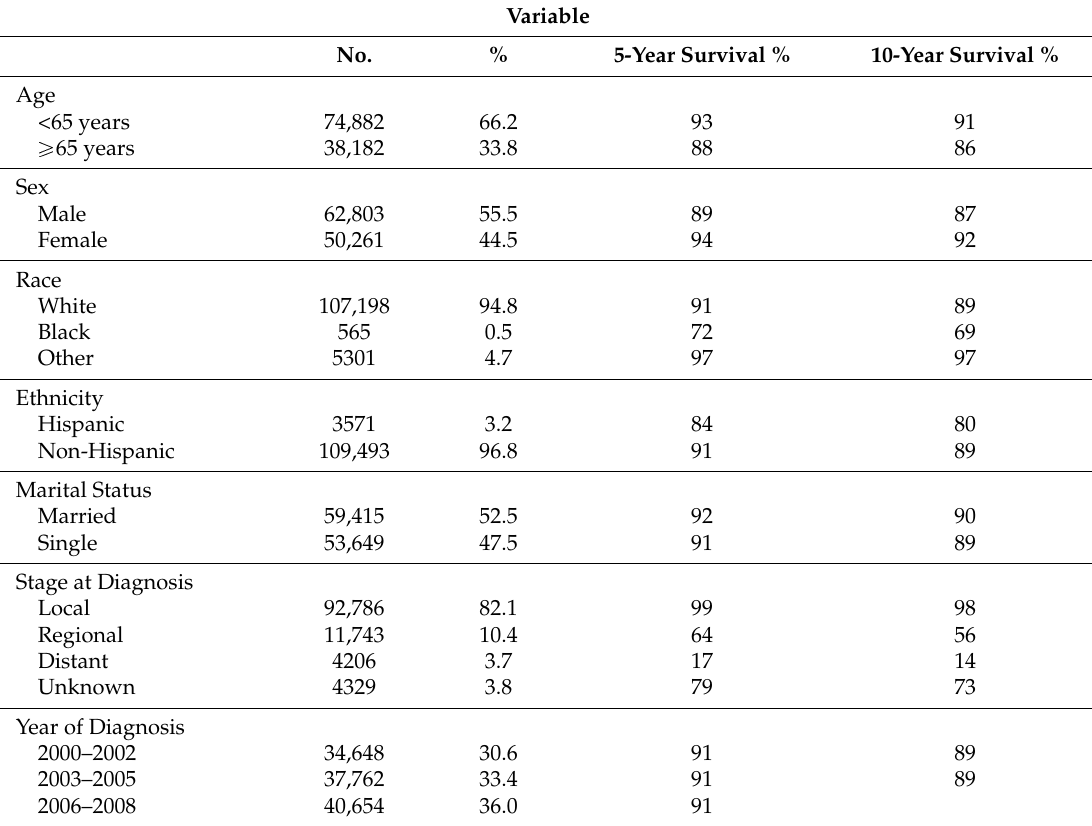
Table 1. Melanoma cases diagnosed during 2000–2008 and relative survival through 2012 according to selected